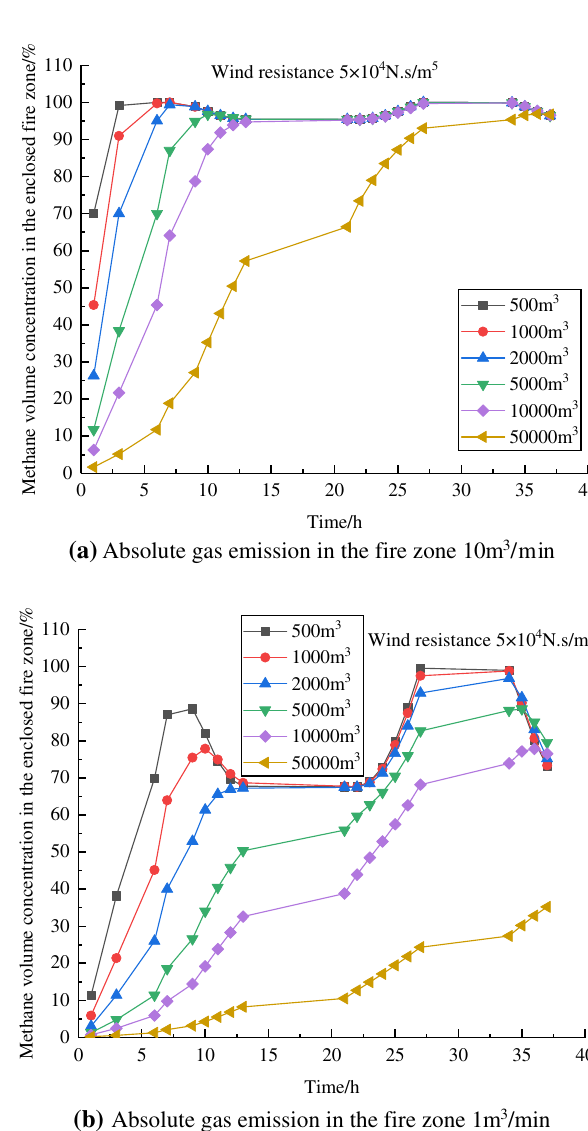
(b) Absolute gas emission in the fire zone 1m 3 /min Fig. 15 The gas concentration in different fire zones, the volume of different fire zones, and the large wind resistance. The changes of gas concentration in the fire zone with time after the completion of sealing at 13:00